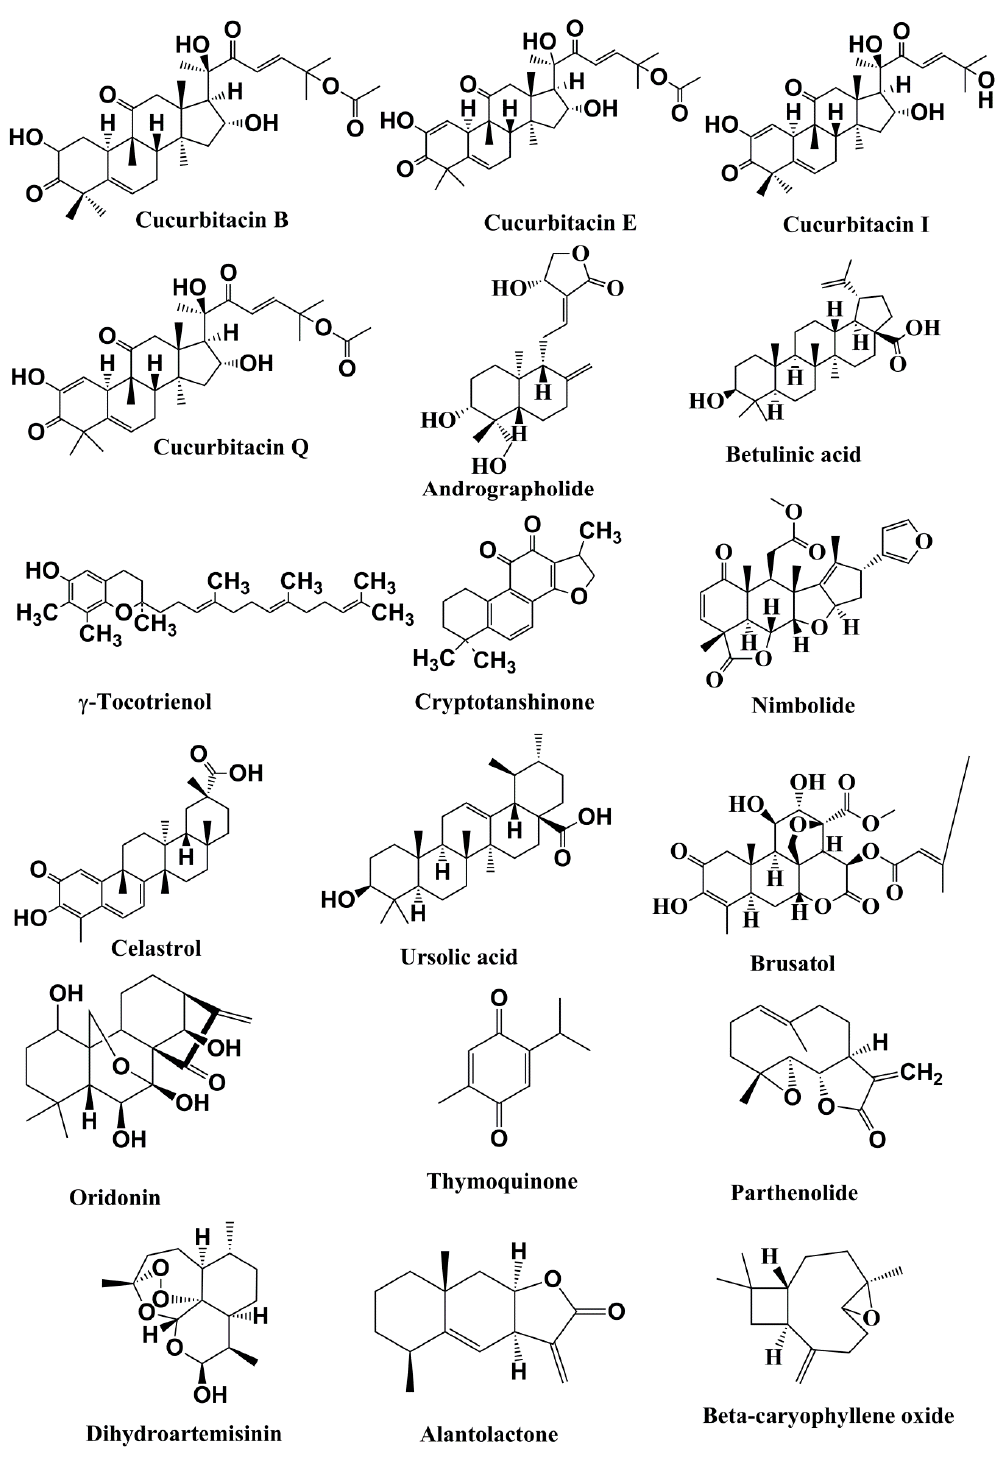
Figure 3. Structures of the terpenoids with anticancer activities related to inhibition of the JAK/STAT